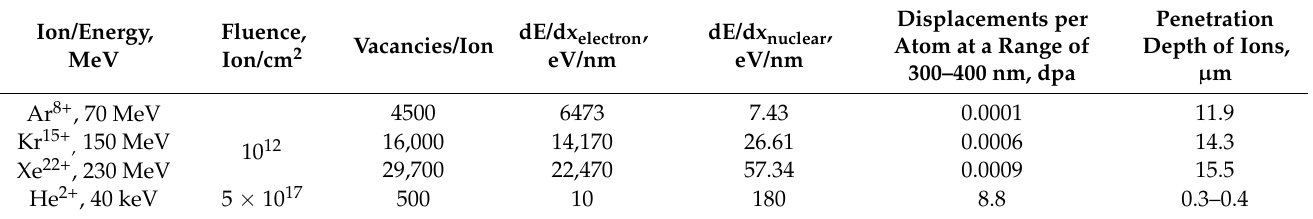
Table 1. Energy-loss results calculated in SRIM Pro